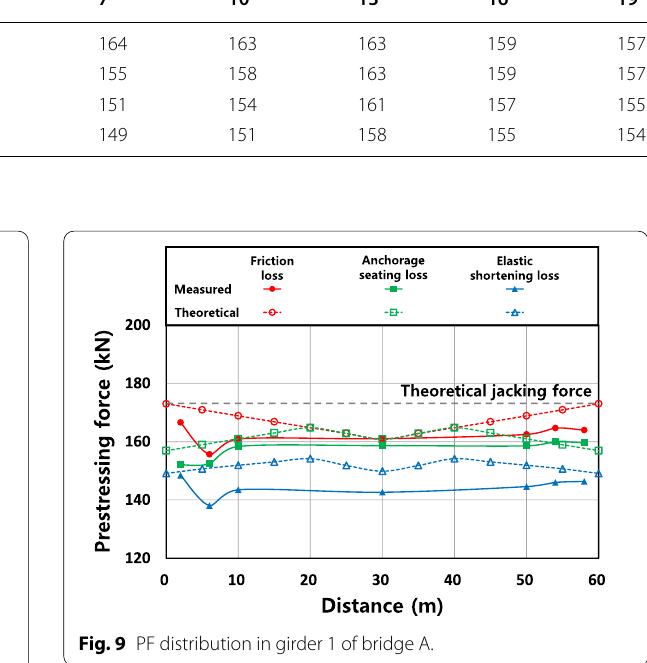
Table 2 PFs at the location of each FBG in full‑scale specimen (T1–H7). Distance (m)